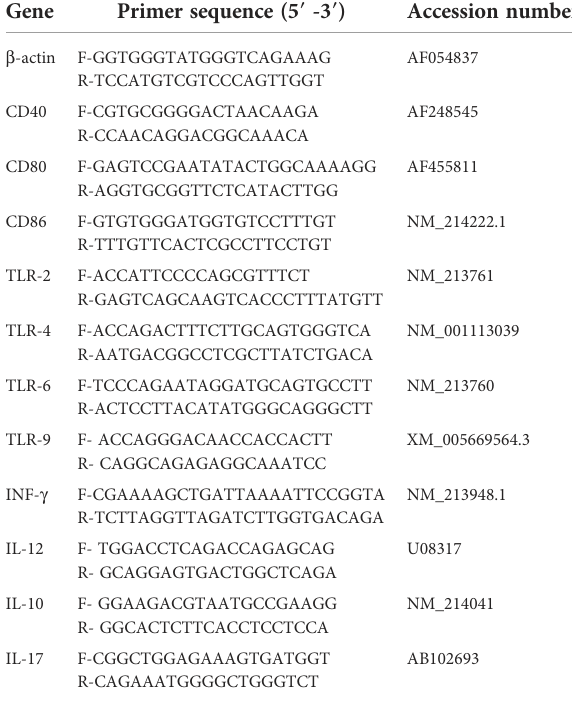
TABLE 1 Details of the speci fi c primer sequences used for qPCR experiments. Gene Primer sequence (5 ′ -3 ′